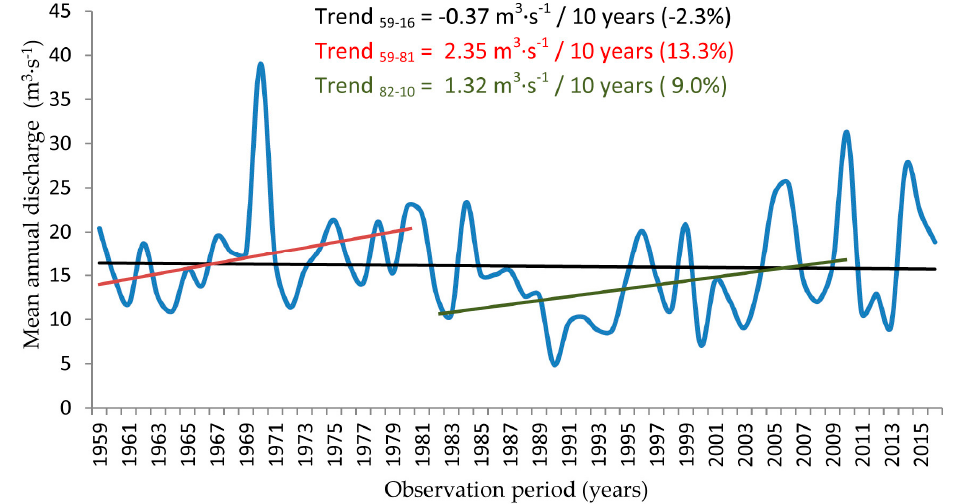
Figure 4. Trend of the mean annual discharge of the Kolubara River measured at the Beli Brod